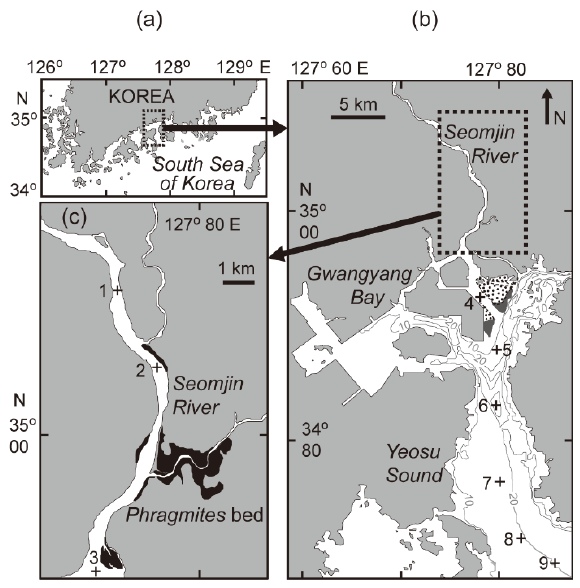
Figure 1. Map showing the location of Gwangyang Bay on the southern coast of the Korean peninsula ( a ), as well as the locations of the sampling stations in the bay ( b ) and in the estuarine channel ( c ). The gray lines represent water depth, and the dotted areas are intertidal beds: dark gray area, Zostera bed ( b ); and dark area, Phragmites bed ( c ).